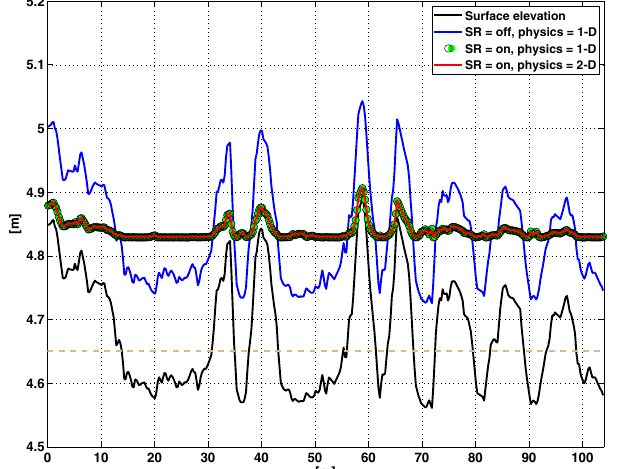
Figure 3. Monthly mean comparison of observation and simulated snow depth (a) in polygon rim and (b) in polygon center; (c) differ- ence between polygon center and rim for 2013.